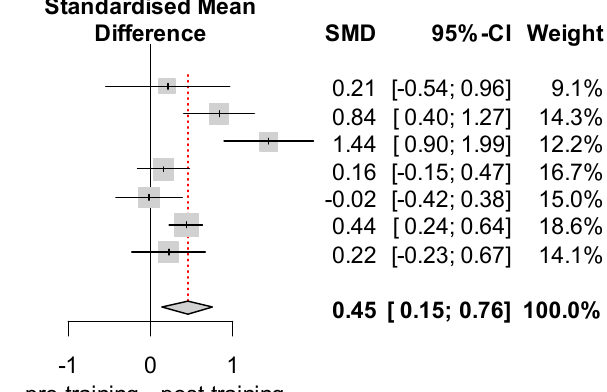
Figure 5. Forest plot—Observed practice.